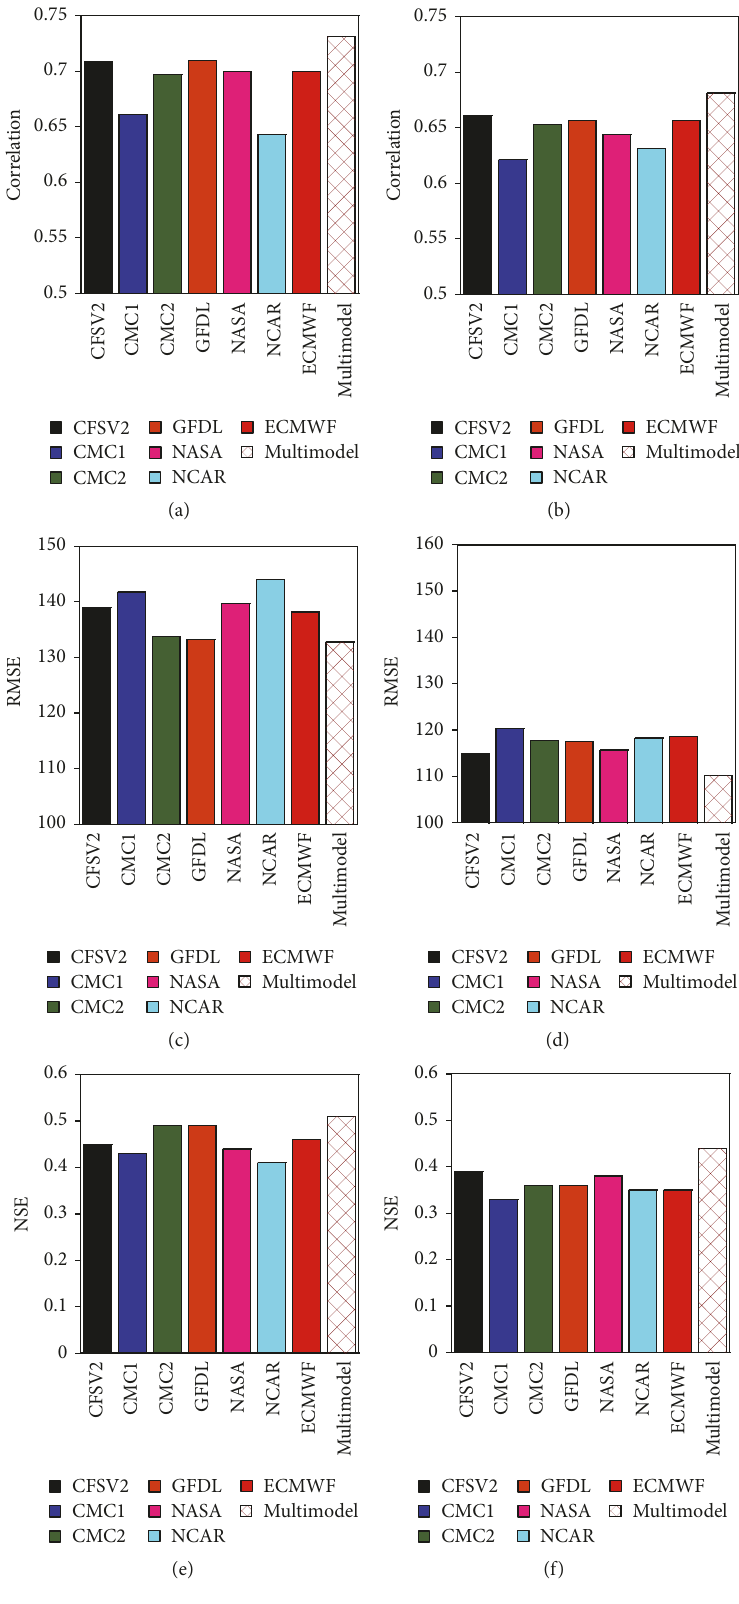
Figure 4: Correlation, RMSE, and NSE for three months’ accumulated predicted versus observed precipitation for the NMME ensemble, CFSV2, CMC1, CMC2, GFDL, NASA, and NCAR models for Northern Figure 2(a) and Central Israel Figure